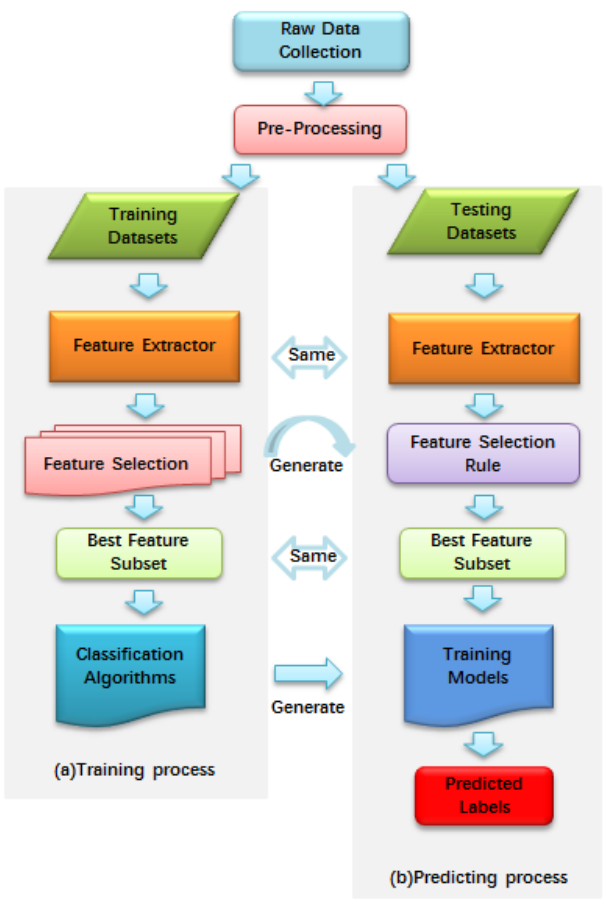
Figure 2. The process framework of conotoxin classification with machine learning methods.